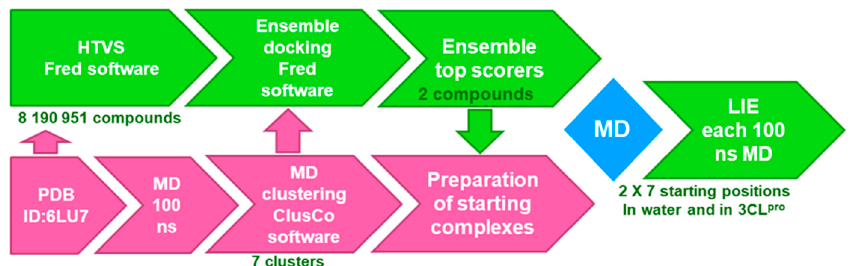
Figure 4. HTVS workflow incorporating ensemble docking coupled to LIE calculations initiated from multiple MD ensemble complexes for the two top-scoring compounds.